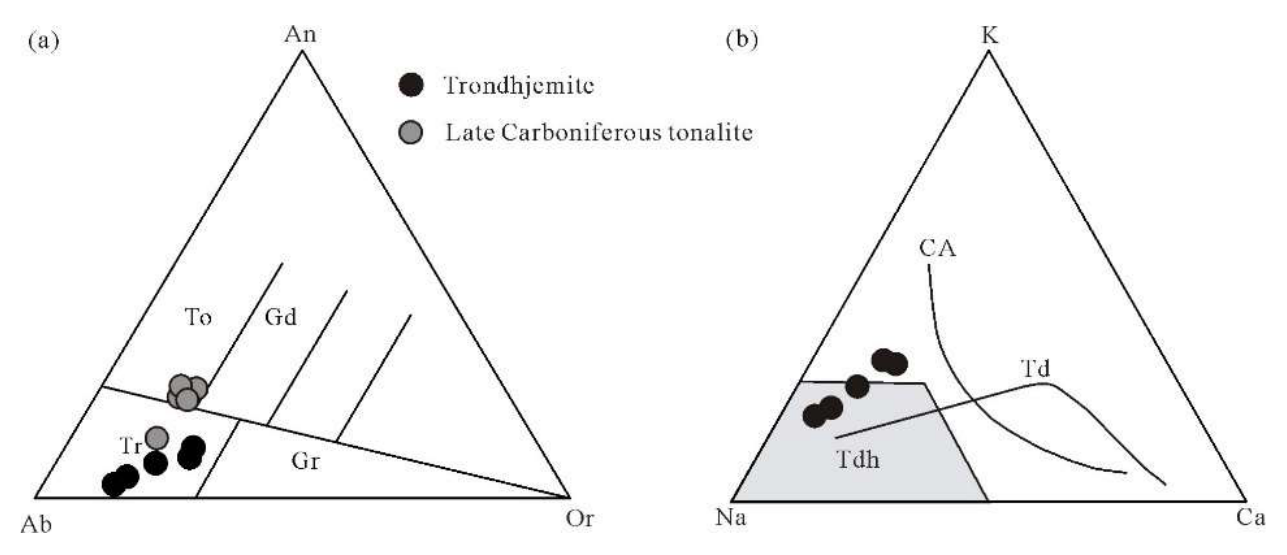
Figure 4. ( a ) Normative An-Ab-Or triangle [43]; ( b ) K–Na–Ca triangle [44]. Late Carboniferous tonalite data from Wang et al., 2021 [41]. To = tonalite; Gd = granodiorite; Tr = trondhjemite; Gr = granite; Td = trondhjemitic differentiation trend; CA = classical calc-alkaline trend characterized by K-enrichment during differentiation.